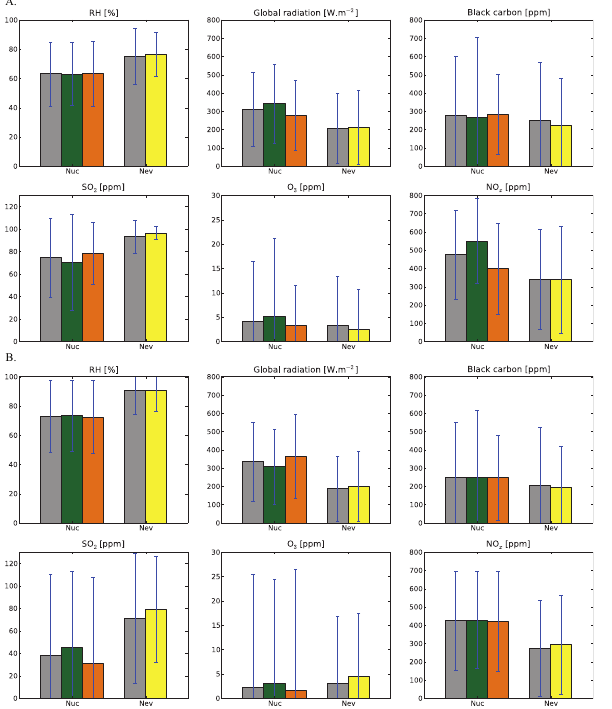
Fig. 6. Average and standard deviation of atmospheric parame- ters measured at the puy de Dˆome station in case of event (Nuc, N =157) or non-event (Nev, N =276) days with or without cloud events filtering (repectively (A) and (B) ) calculated over the 09:00– 11:00 time period. Grey bars represents the general case, when the nucleation is observed at the puy de Dˆome station (Nuc) or not (Nev). The green and the orange bars are respectively for a nucle- ation events that occur only at the puy de Dˆome station ( N =70) and an event that occur at both measurement sites ( N =87). The yellow bar is for events that only occur at the Opme station ( N =4).